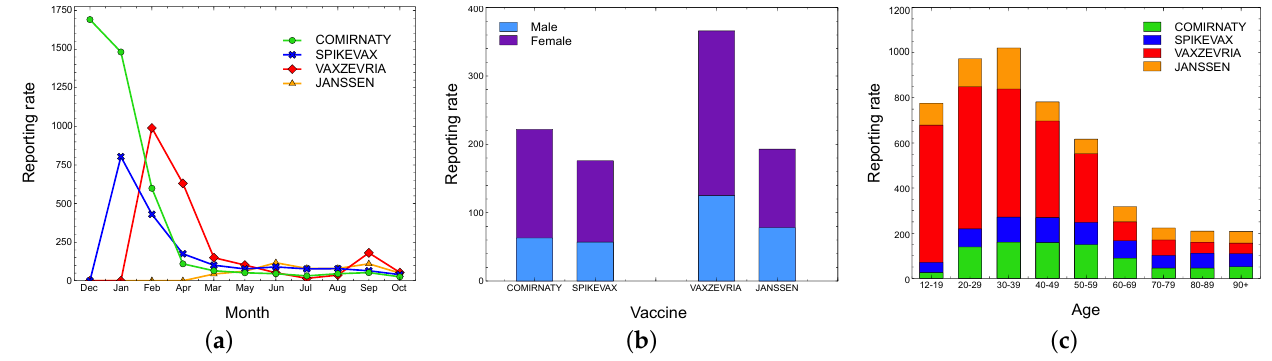
Figure 7. Main results of pharmacovigilance activities of AIFA: reporting rate vs. time ( a ), and distribution by sex ( b ) and by age ( c